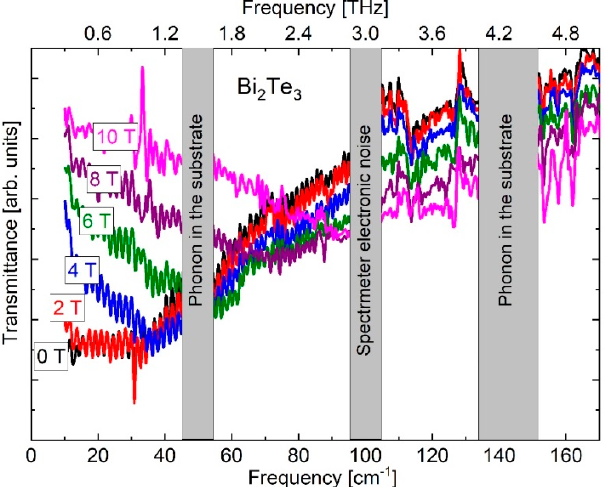
Figure 1. Raw transmission spectra of Bi 2 Te 3 films on BaF 2 substrates as obtained in magnetic fields of up to 10 T. The areas with low signal due to either the substrate phonons or spectrometer electronic noise are shaded. The signal-to-noise ratio is best at around 80 cm − 1 and becomes appreciably lower as frequency increases (see also Figure 2), preventing thus any meaningful measurements of the cyclotron resonance (CR) mode at the fields higher than 10 T.